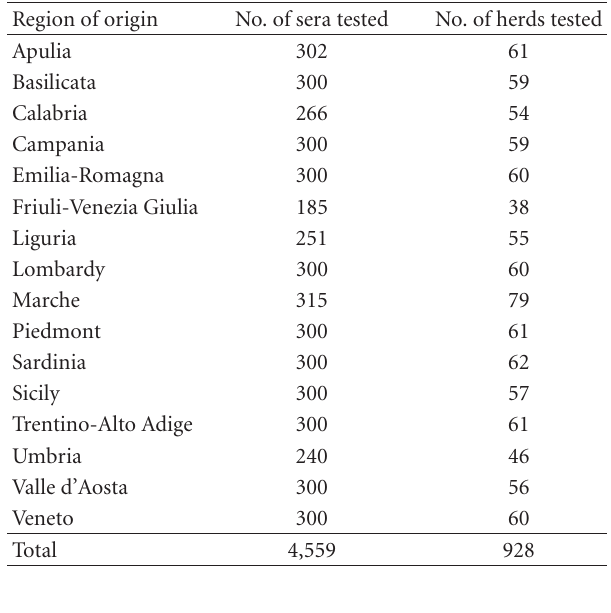
Table 2: Number of sera from the National Brucellosis Eradication Program (NBEP, collected during year 2004) and tested with RB51- CFT, on regional basis.